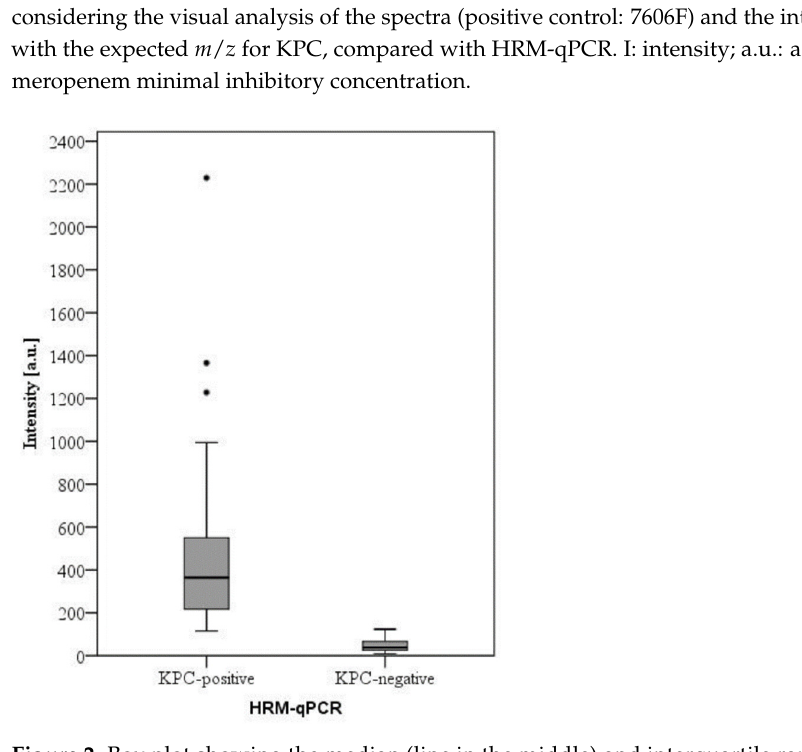
Figure 2. Box plot showing the median (line in the middle) and interquartile range calculated from the intensities of the 28,698 Da peak in the bla KPC -positive and negative isolates. Dots above the whiskers indicate the outliers. The x and y axes show the HRM-qPCR result and intensity (arbitrary units—a.u.), respectively.